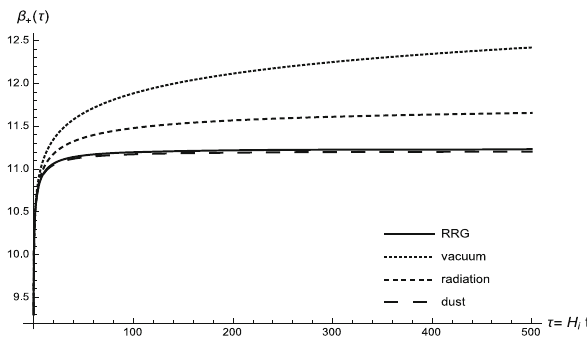
Fig. 7 Plots of β + for the moderate warmness. Parameters are as fol- ( i ) = 0 . 99 with the initial condition β + = 10 lows: b = 0 . 5, Ω ani